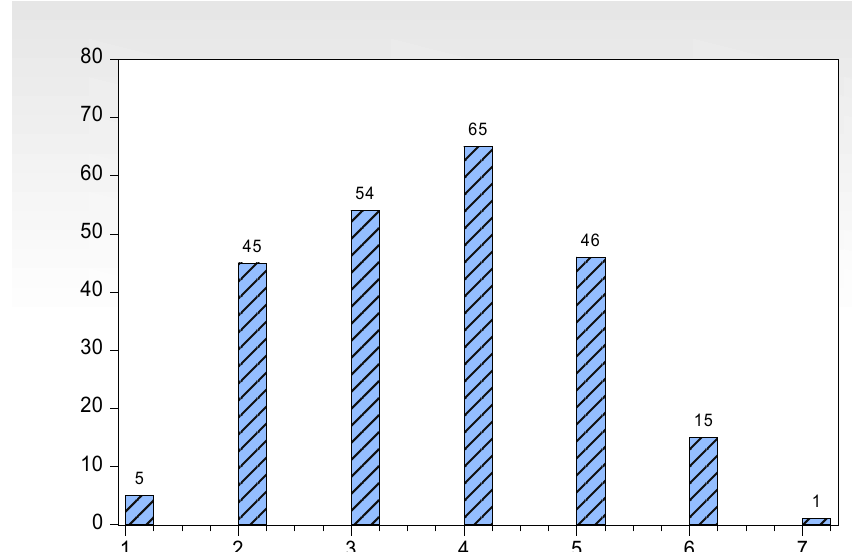
Figure 1. The frequency distribution charts on the items of effective impact evaluated indicators after the implementation of HMEAYC.